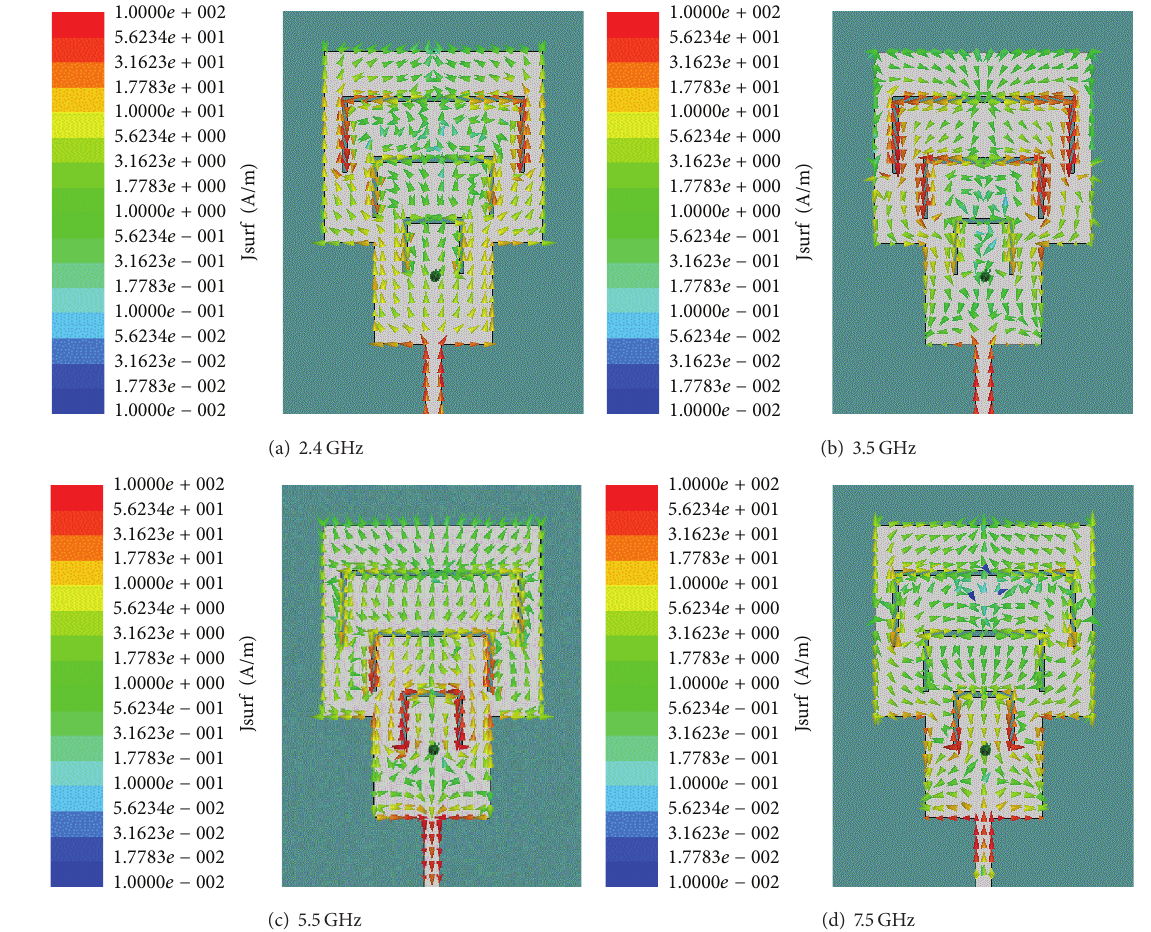
Figure 6: Maps of the surface current distributions at the frequency of (a) 2.4 GHz, (b) 3.5 GHz, (c) 5.5 GHz, and (d) 7.5GHz.